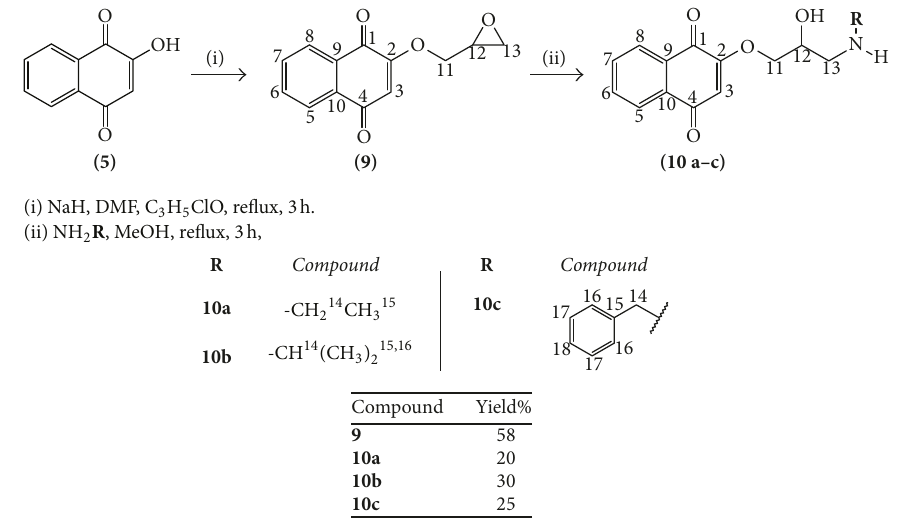
Scheme 2: Synthesis of naphthoquinones 9 and 10a–c and their